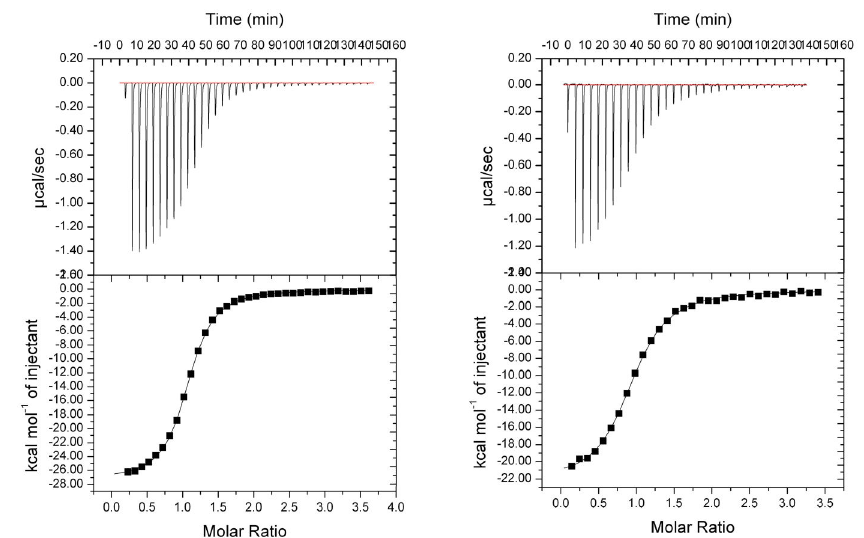
Figure 3. Representative isothermal titration of rat (left) and human (right) DNPH1with inhibitor 6, best-fitted with one- site binding model. doi: